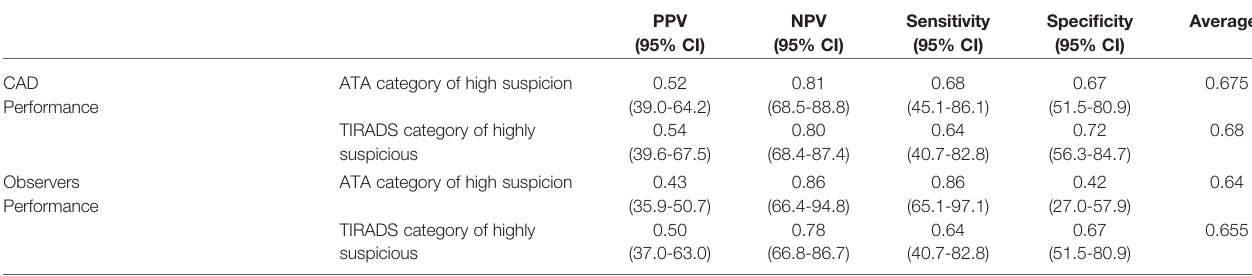
TABLE 5 | Comparison between CAD and